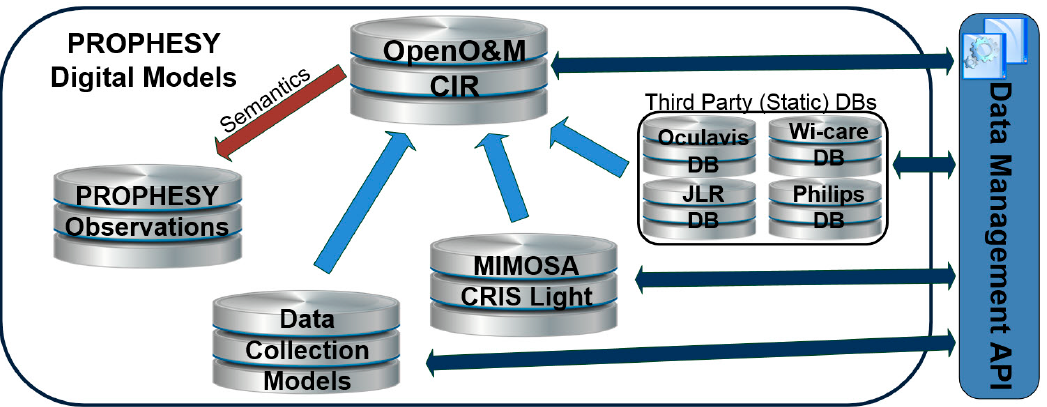
Figure 6. Concept of CIR Approach as implemented in the PROPHESY Project.